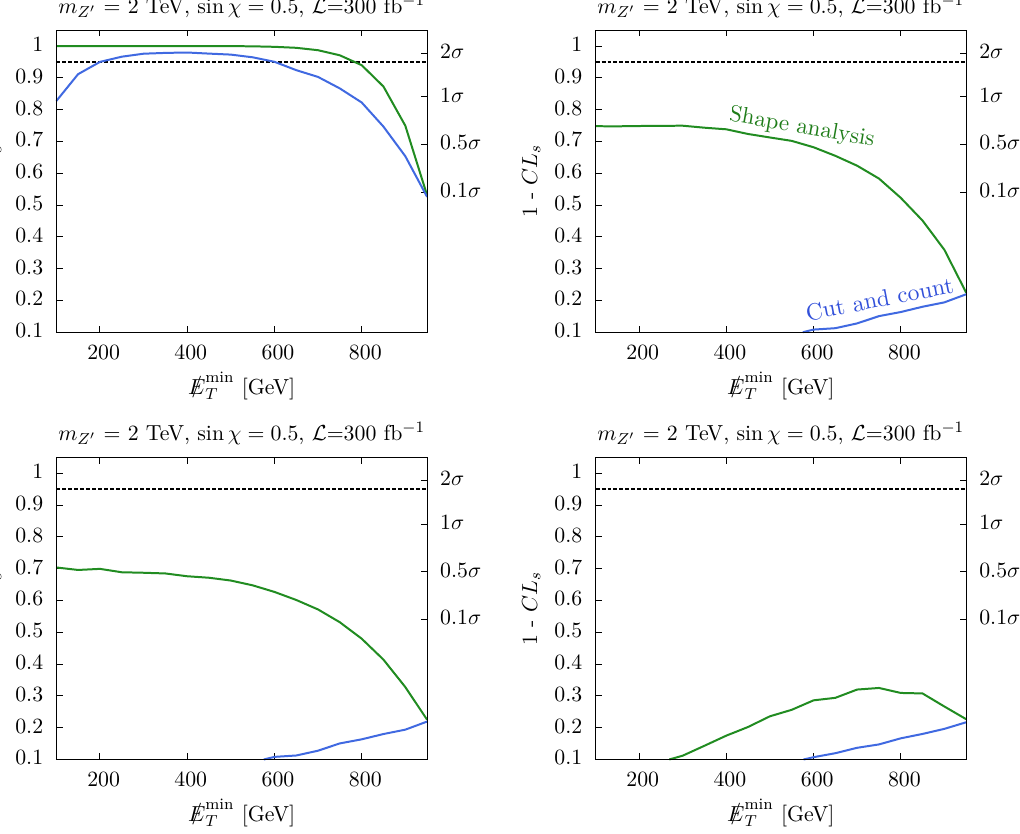
Figure 14: Expected C L for excluding the signal hypothesis from a / E distribution in s T mono-jet events as a function of minimum / E . We show the results from a full shape T analysis (green) vs counting all events above the cut as a single bin (blue). Four systematics scenarios are considered: no systematics (top-left), an uncorrelated 5% per-bin background uncertainty (top-right), a 5% per-bin background uncertainty plus 100% correlation between neighbouring bins (bottom-left), and a 5% uncer- tainty fully correlated across all bins